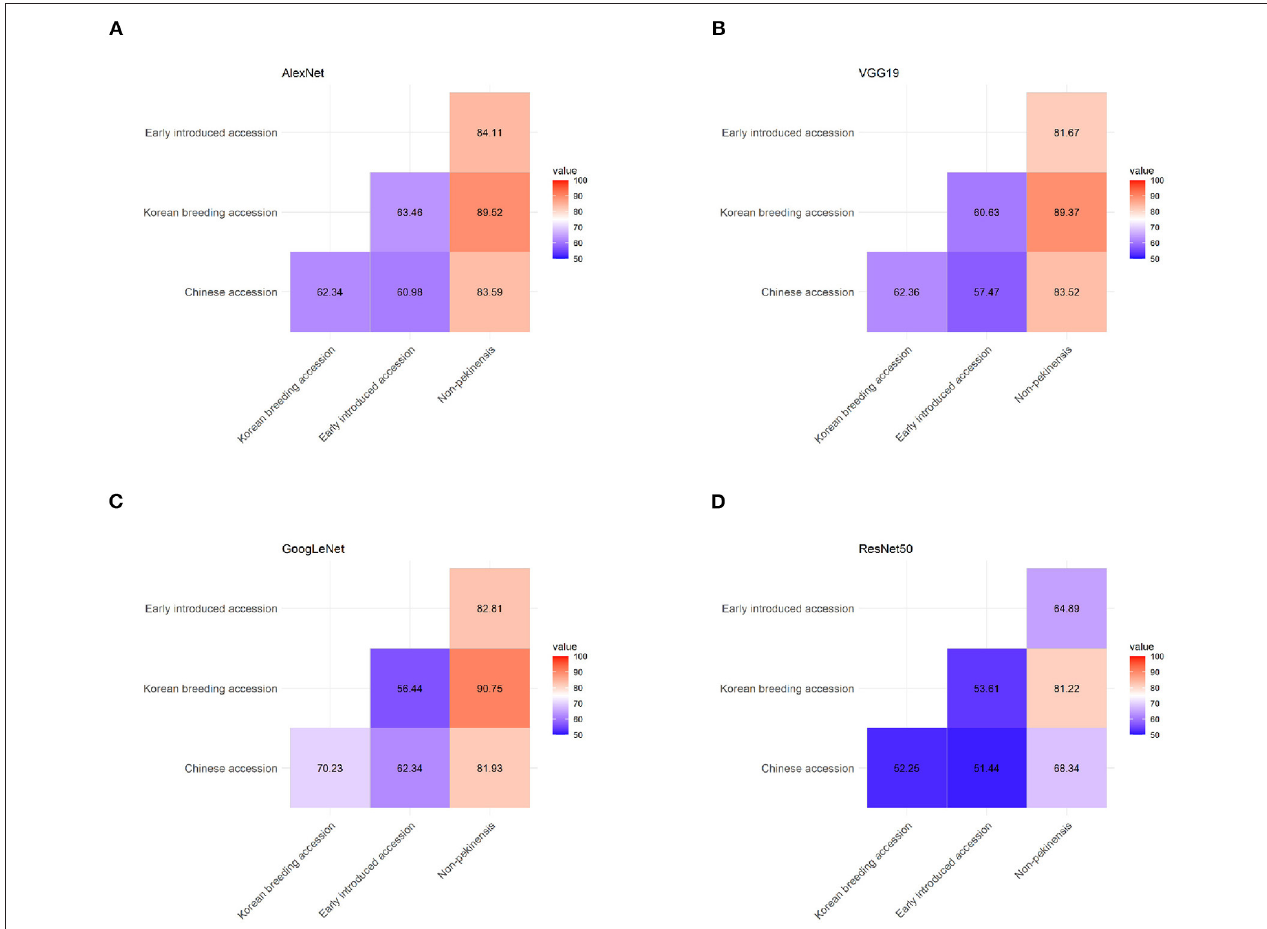
FIGURE 5 | Classification accuracy in pairwise tests using the four types of accessions (Chinese, early introduced, Korean breeding, and non-pekinensis) with four different architectures: (A) AlexNet, (B) VGG19, (C) GoogLeNet, and (D)